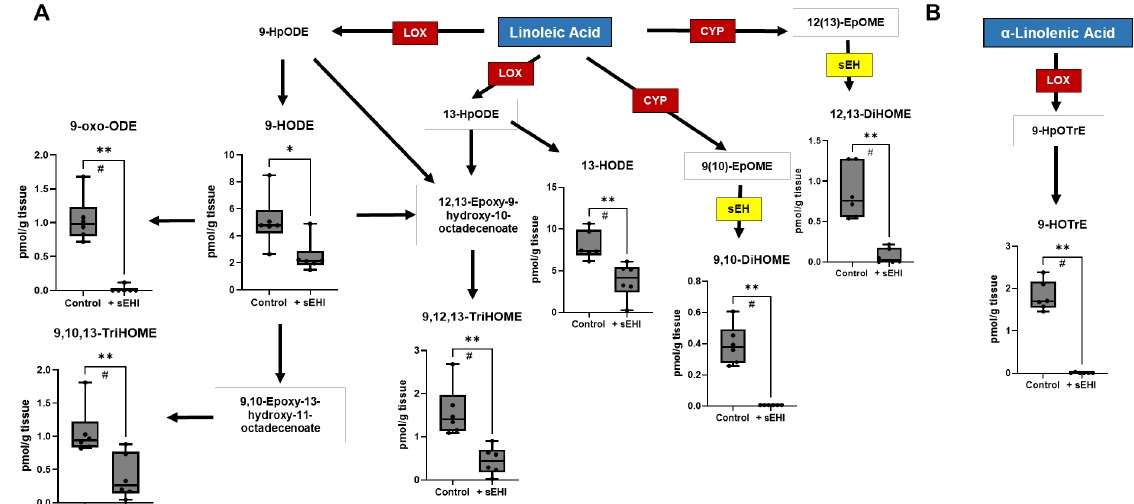
Figure 4. Oxylipins downstream of linoleic acid and α-linolenic acid altered by sEHI in males. Boxplots of oxylipins that were significantly different in the brains of male sEHI-treated and control mice are shown in a diagram demonstrating the pathways producing the oxylipins from linoleic ( A ) and α -linolenic ( B ) acid. The box extends from the 25th to the 75th percentile, with the middle line indicating the median. The whiskers extend to the minimum and maximum values, with in- dividual values indicated by black dots. For definitions of oxylipin abbreviations see Table S1. LOX: lipoxygenase enzyme; CYP: cytochrome p450 enzyme; sEH: soluble epoxide hydrolase; * p < 0.05; ** p < 0.01; # FDR adjusted p <